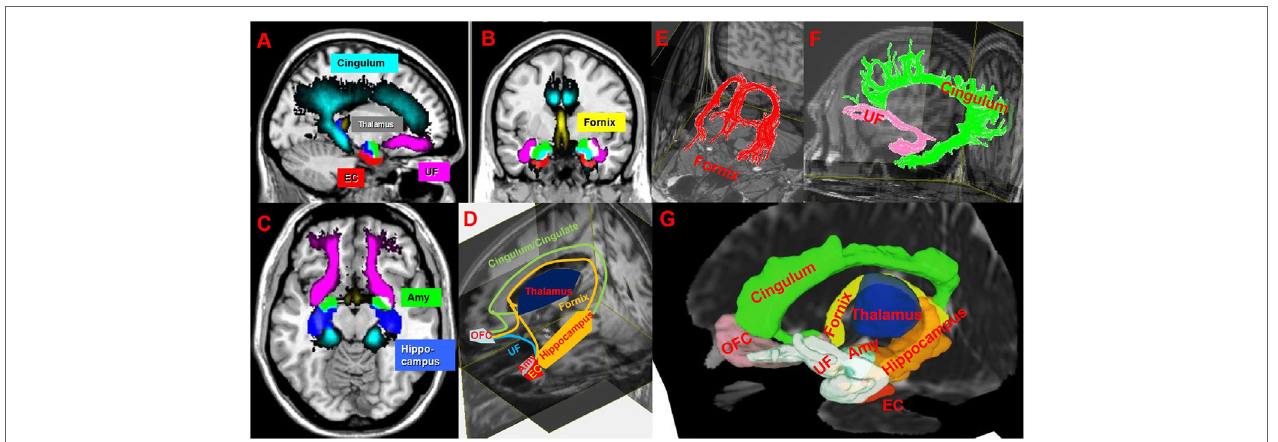
FigUre 1 | (a–c) Illustration of spatial-normalized MNI summary of cingulum, fornix, uncinated fasciculus (UF), thalamus, entorhinal cortex (EC), amygdala (Amy) in sagittal, coronal and axial T1w slices in our multiple sclerosis (MS) cohort. (D,g) Schematic (D) and atlas-based (g) representation (in one MS patient) of limbic connections between limbic gray matters on 3D T1w and mean diffusivity images. (e,F) Illustrates cingulum (green), UF (pink), and fornix (red) on T1w. Abbreviation: OFC, orbitofrontal cortex. MRIcron (http://people.cas.sc.edu/rorden/mricron/index.html), Diffusion tensor imaging (http://cmrm.med.jhmi.edu/), and DSI (http:// dsi-studio.labsolver.org/) studios are used to generate this figure.